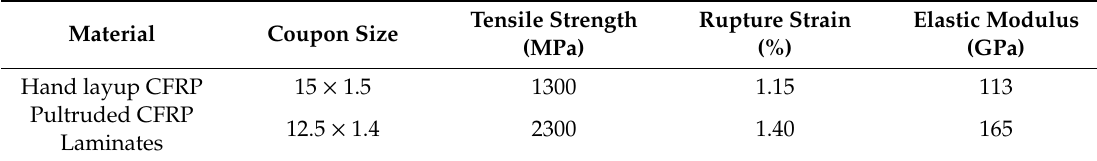
Table 2. Material characteristics of FRP